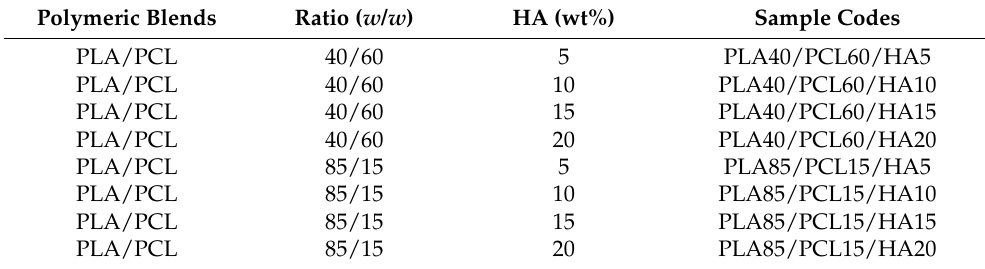
Table 2. Coding and composition of samples studied.